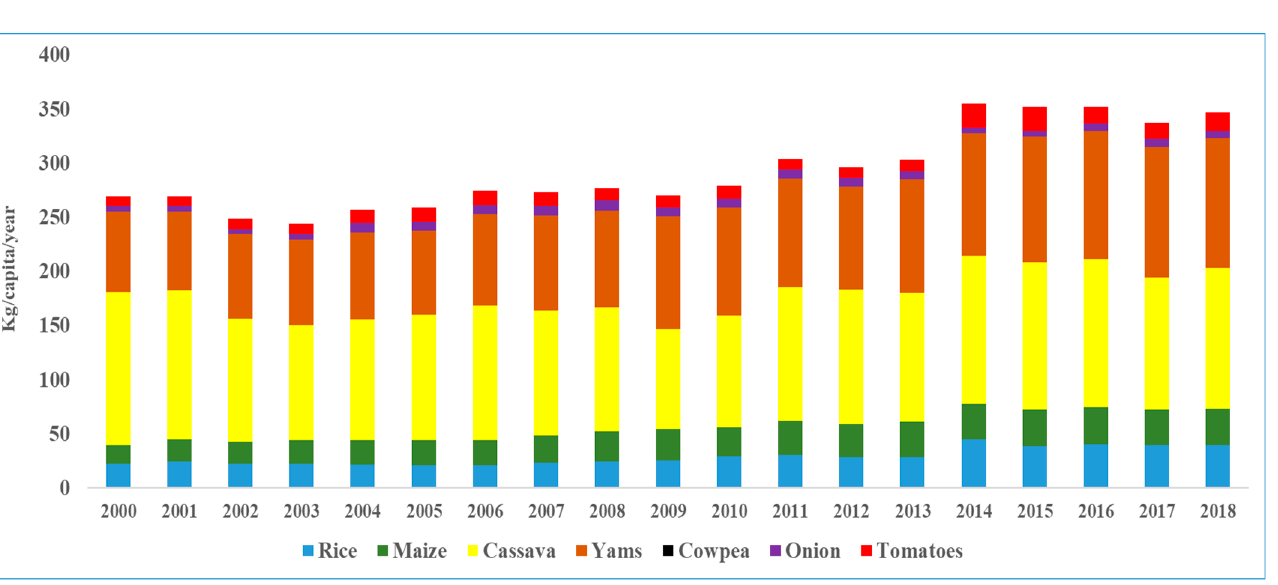
Figure 4. Nigeria food consumption pattern (kg/capita/year) from 2000 to 2018 (FAOSTAT).